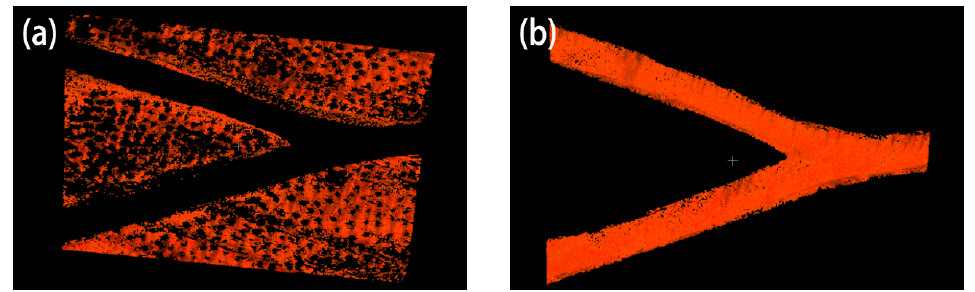
Figure 29. The ski-track was extracted from the Figure 25b: ( a ) is non-ski-track points; ( b ) is ski-track points.